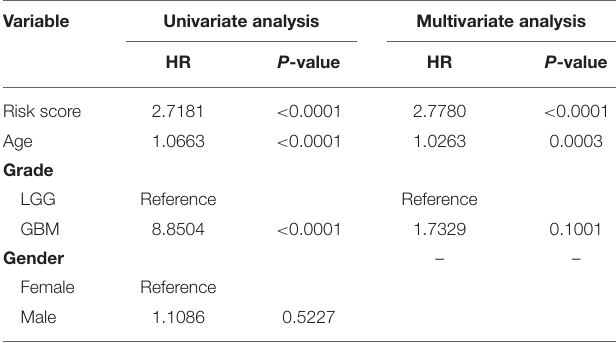
TABLE 3 | Univariate and multivariate analysis of the risk signature and clinical prognostic factors in the training cohort.